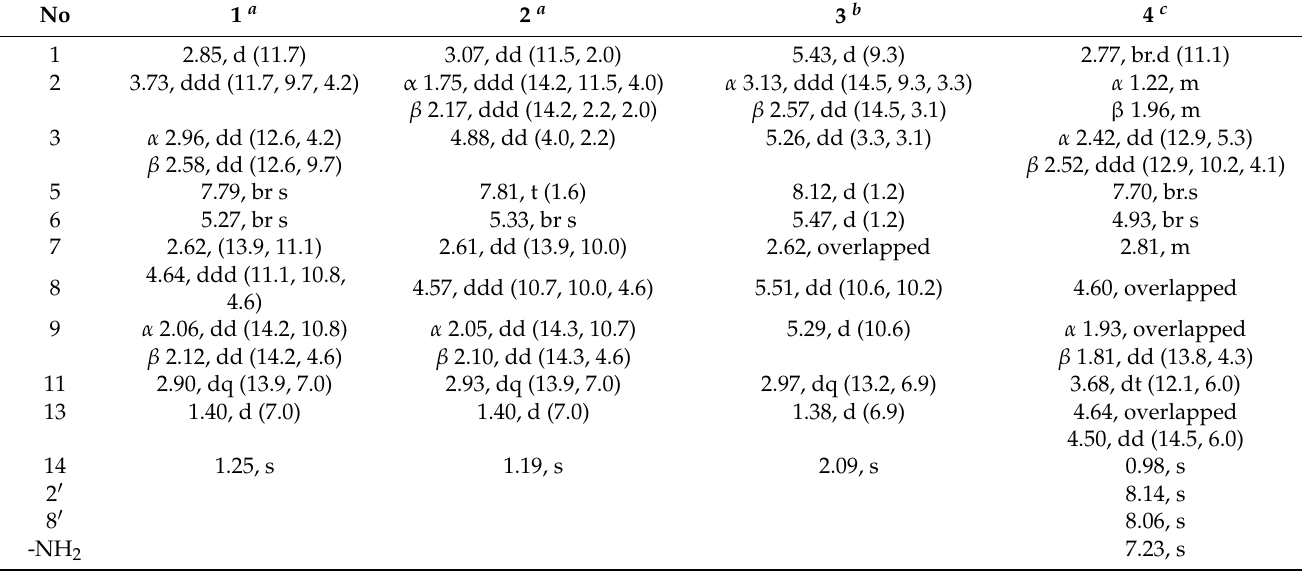
Table 1. 1 H NMR data of compounds 1 – 4 , δ in ppm and J in Hz.